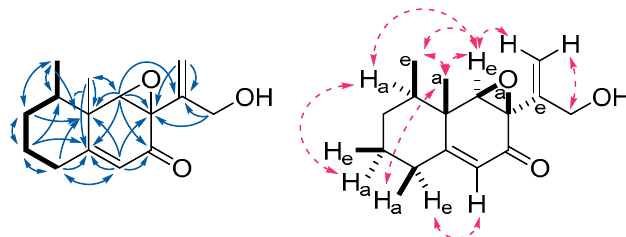
Figure 6. Key nuclear magnetic resonance ( NMR ) correlations of phoenixilane A ( 1 ) . Left : structure with 1 H / 1 H Correlation Spectroscopy- ( COSY; bold bonds) and 1 H / 13 C Heteronuclear Multiple Bond Correlation ( HMBC ) correlations ( blue arrows). Right : relative conformation with Rotating Frame Nuclear Overhauser Effect Spectroscopy ( ROESY ) correlations ( dashed, pink arrows); conformation of ring substituents: a: axial, e: equatorial.